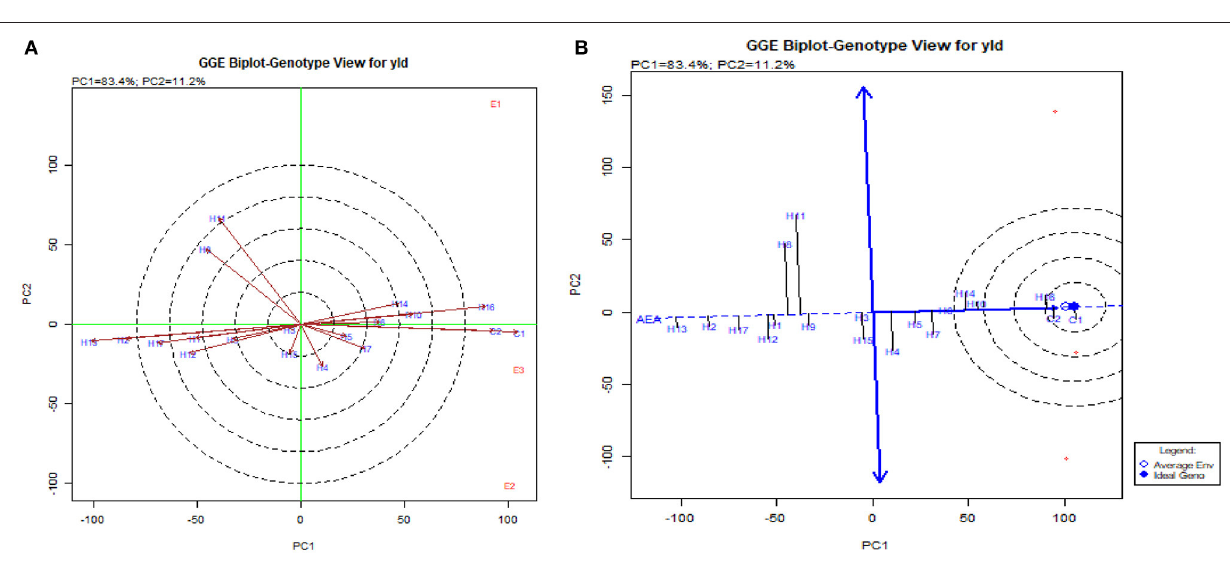
Frontiers in Plant Science |